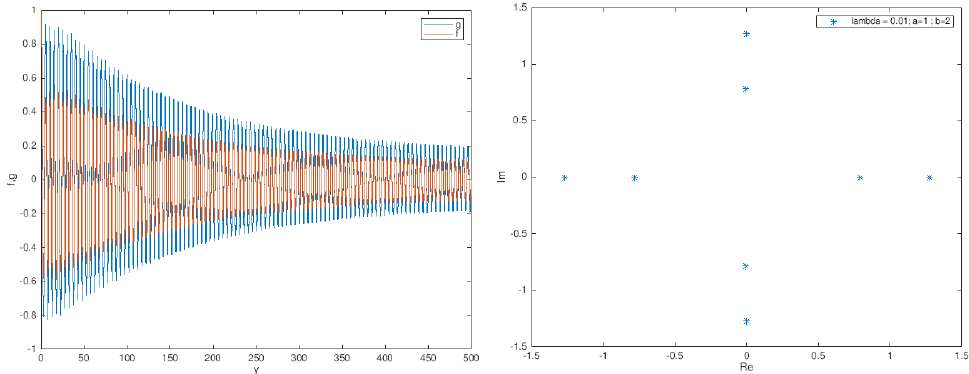
Figure 13. TW for a = 1, b = 2, λ = 0.01 ( left ) and associated homotopy graph. Note that the advection term (cid:101) << λ 0 ∼ λ ( right